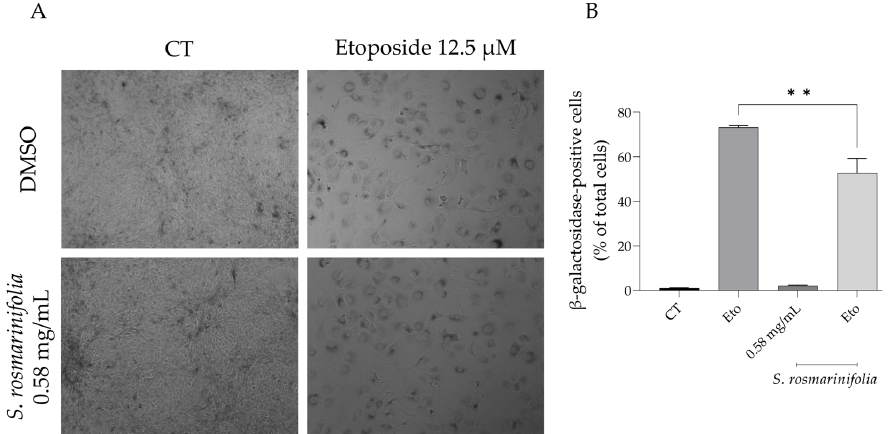
Figure 8. Santolina rosmarinifolia reduced senescence-induced β -galactosidase activity. ( A ) Represen- tative bright-field images of NIH 3T3 cells treated with 24 h of etoposide (Eto, 12.5 µ M) followed by 72 h in the presence or absence of S. rosmarinifolia (0.58 mg/mL). ( B ) Percentage of senescence-induced β -galactosidase-positive cells. Results show the mean ± SEM of three independent assays made in duplicate. ** p < 0.01 when compared to etoposide